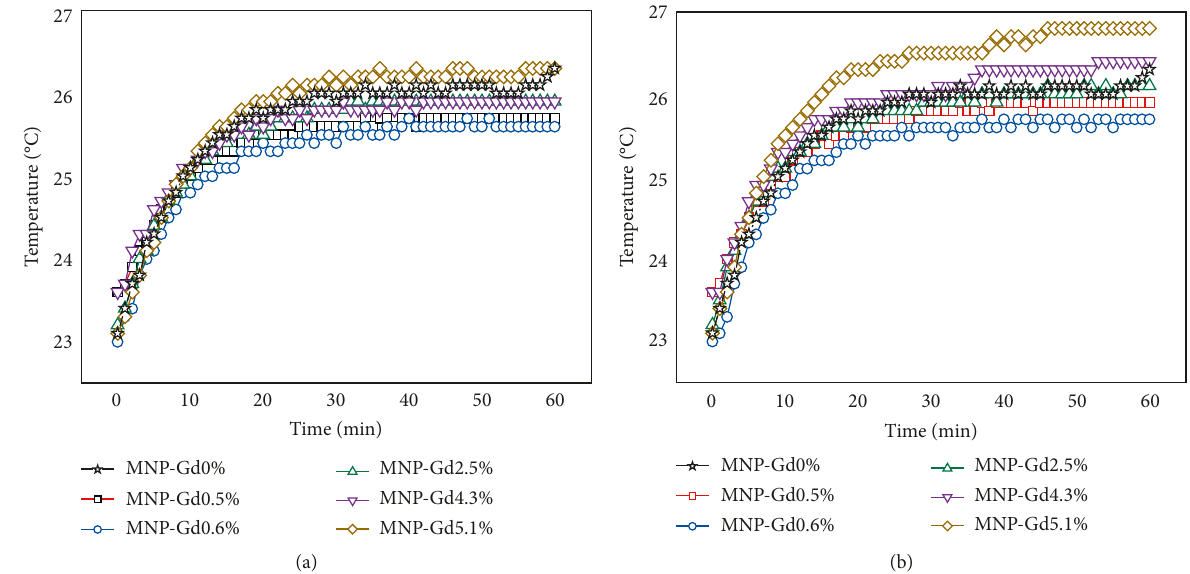
1 spectral interval reporting the absorption band centered at − 1 for MNP-Gd0% and MNP-Gd5.1% samples with fitting results. − 27